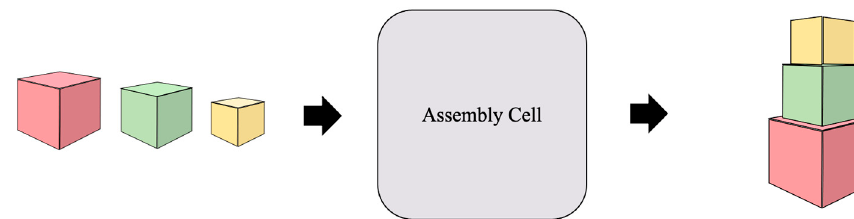
Figure 1. Assembly process.